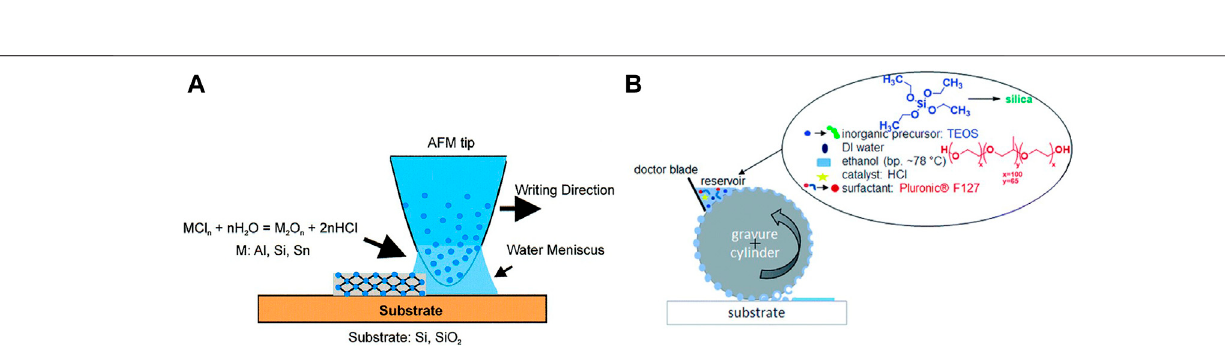
Frontiers in Materials |